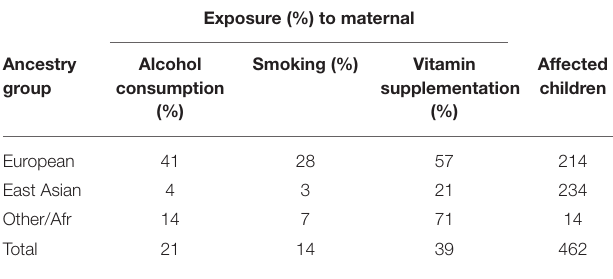
TABLE 2 | Exposure rates for maternal alcohol consumption, maternal smoking, and maternal vitamin supplementation for the total CP group and for three ancestral